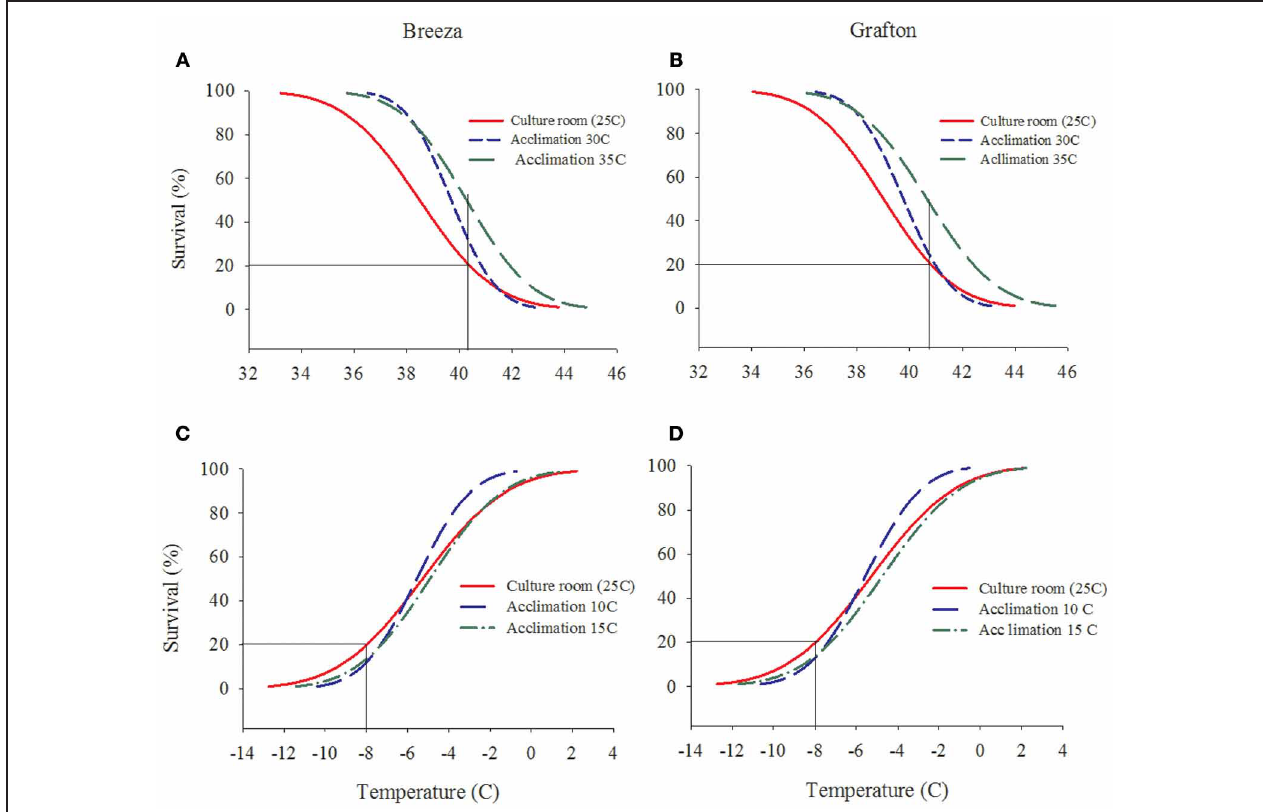
FIGURE 2 | The effects of acclimation temperature on the upper and lower lethal temperature of Nezara viridula (L.) population from Breeza (A and C) and Grafton (B and D) (raw data omitted for clarity).